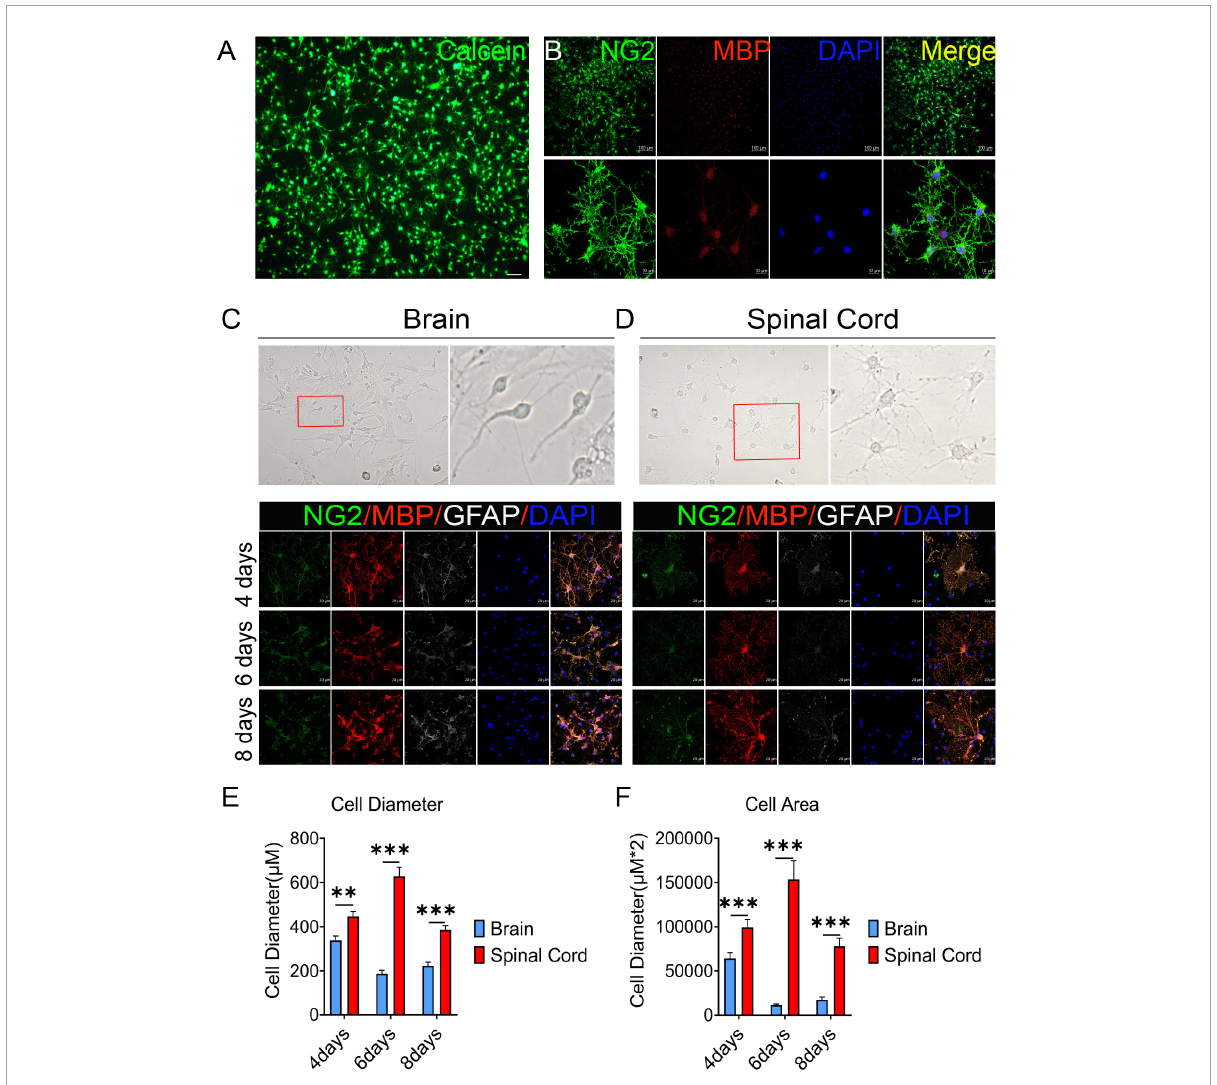
FIGURE1 The oligodendrocyte progenitor cells (OPCs) differentiation and oligodendrocytes morphology are different between the brain and spinal cord. (A,B) OPCs with > 95% purity were obtained (by cell count) and identified by Calcein AM staining and the expression of oligodendrocyte lineage cell markers NG2 (green) and MBP (red). (C,D) Spinal cord-derived OPCs were easier to differentiate and mature than brain-derived cells. Immunofluorescence staining of NG2 (green), MBP (red), and GFAP (white) was used to detect the dynamic changes in oligodendrocytes. n = 3 biological repeats. Scale bars are indicated in the pictures. (E,F) The histograms showed the statistical results of oligodendrocytes diameter and area. n = 3 biological repeats. Values are the mean ± SEM. Statistical significance was determined by one-way ANOVA followed by Student Newman–Keuls post-hoc test. ∗∗ P < 0.01, ∗∗∗ P <